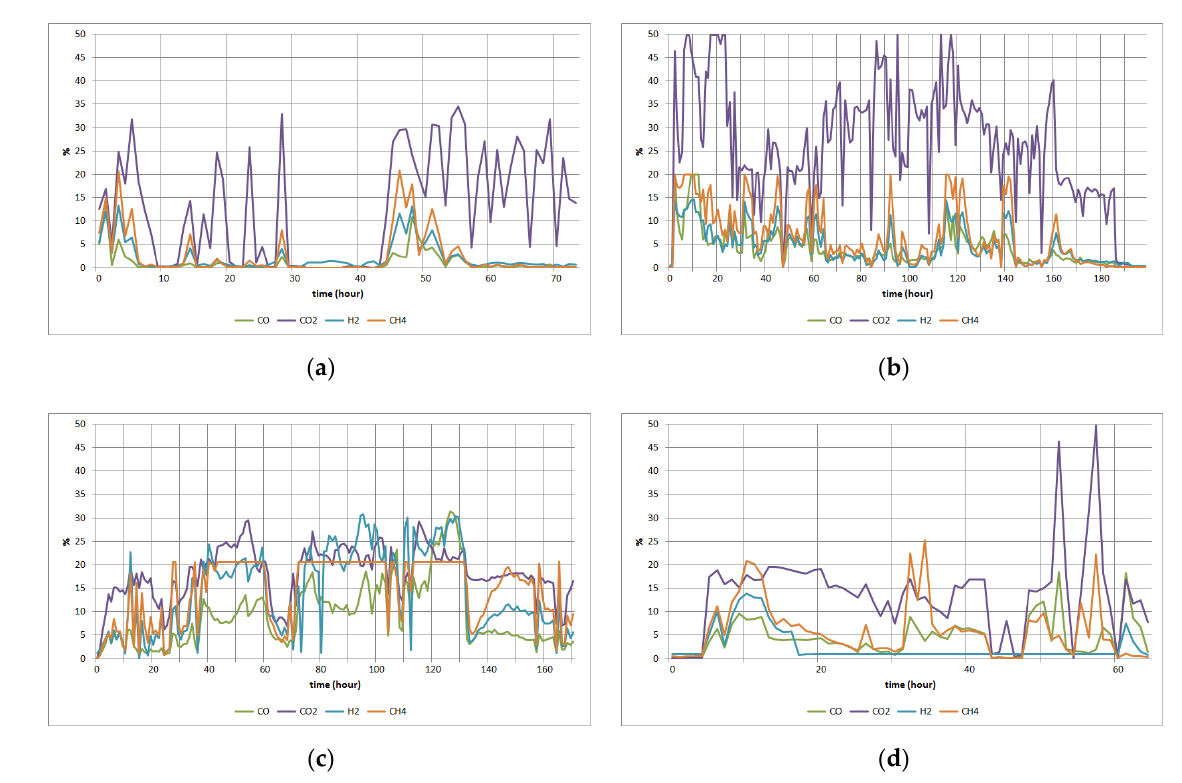
Figure 4. The behavior of%CO,%CO 2 ,%H 2 ,%CH 4 in syngas during experiments for the ( a ) experiment #1, ( b ) experiment #2, ( c ) experiment #3, ( d ) experiment #4.